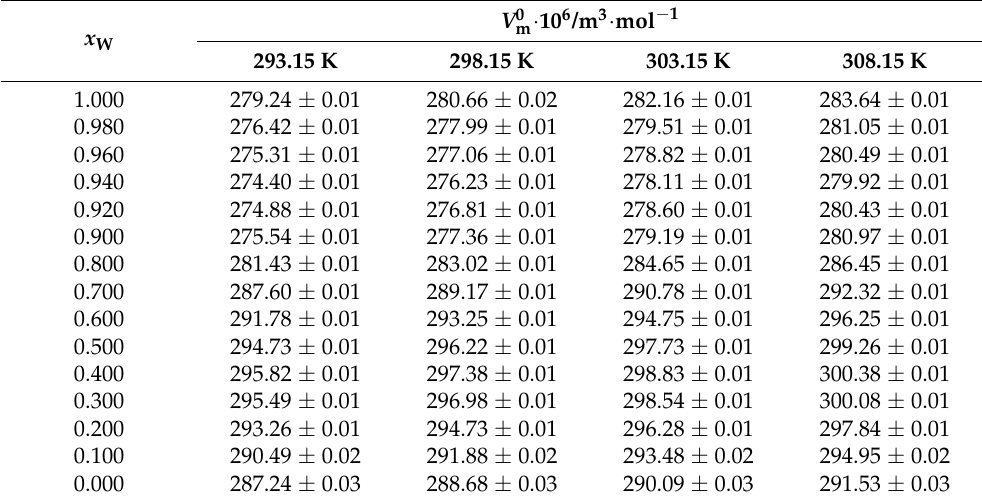
Table 2. Limiting partial molar volume of hexaglyme in the DMF + W mixed